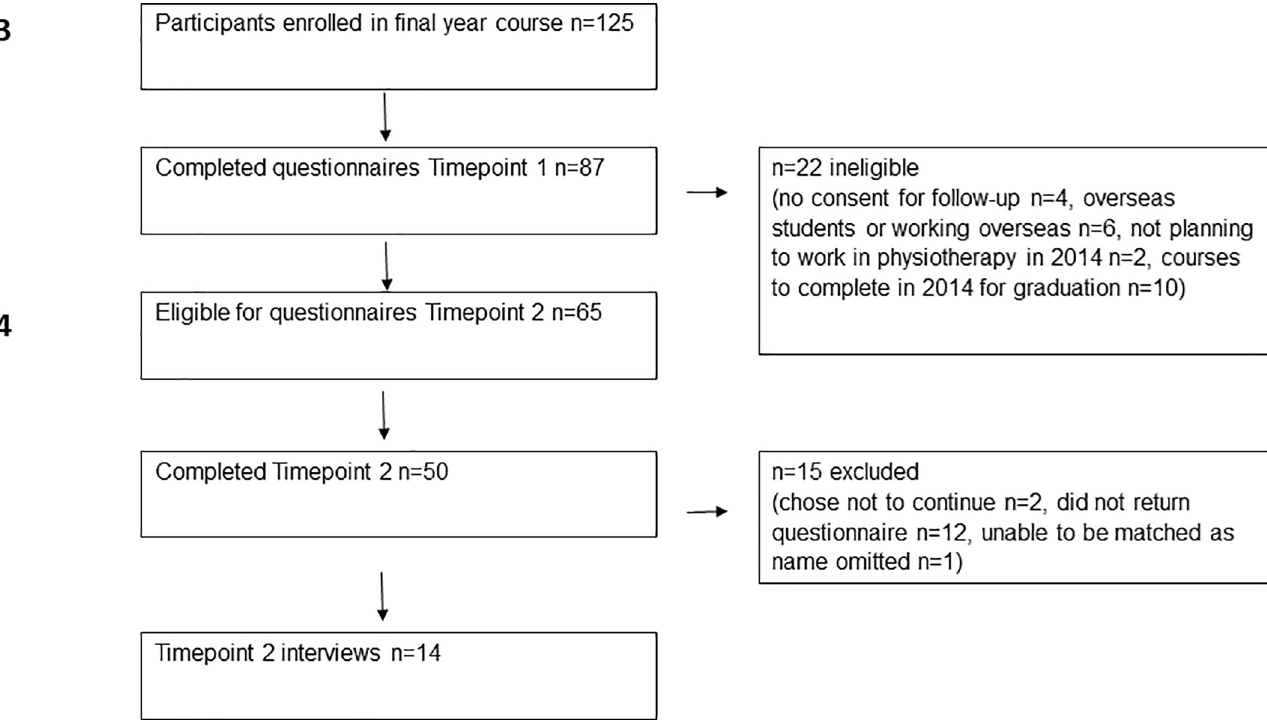
Fig 1. Flow of participants through the